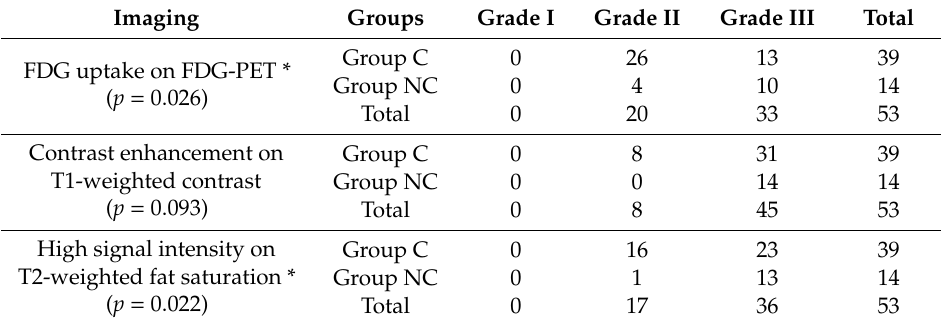
Table 6. Distribution-based interpretation: FDG uptake on FDG-PET, contrast enhancement of T1-weighted contrast on MRI, and high signal intensity of T2-Weighted fat saturation on MRI. Imaging